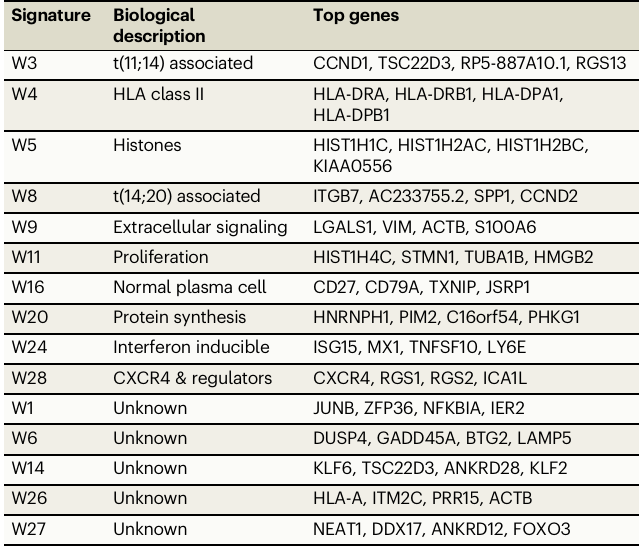
Table 1 | 15 gene expression signatures discovered using ARD- NMF ( “ patient-speci fi c ” and “ single-gene ” signatures are not included; see Supplementary Table 8 for the full list of